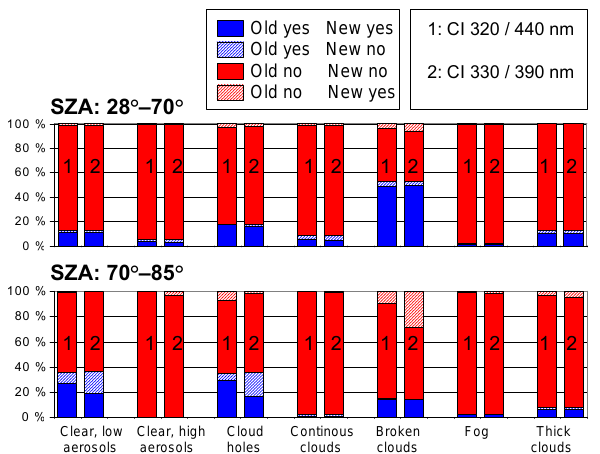
Figure 14. Comparison of the results of the original and updated classification scheme. The black numbers indicate the comparison results between the original algorithm and the updated algorithm using CI orig (1) and between the original algorithm and the up- dated algorithm using CI new (2). Blue and red colours represent cases which were assigned or not assigned to the respective class by the original algorithm. Bars with full colours indicate agreement between the old and new algorithm, hatched bars indicate disagree- ment between the old and new algorithm.